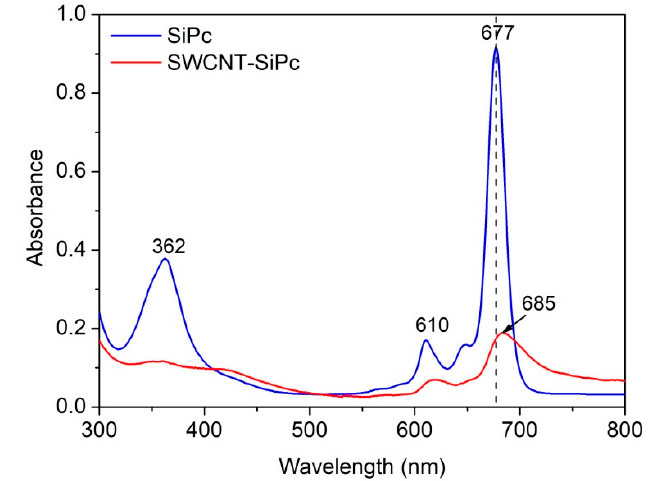
Figure 4. UV-Visible electronic absorption spectra of SiPc and its SWCNT / SiPc hybrid nanomaterial in DMF.